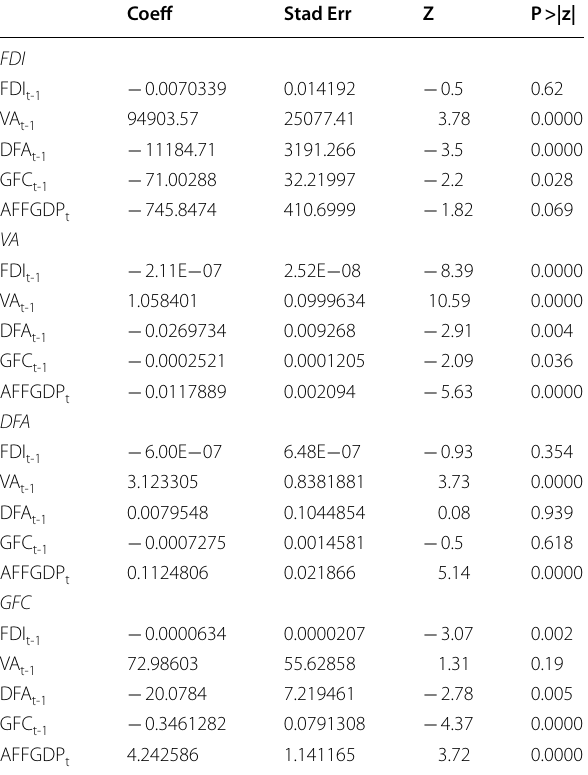
Table 7 Panel vector autoregression GMM